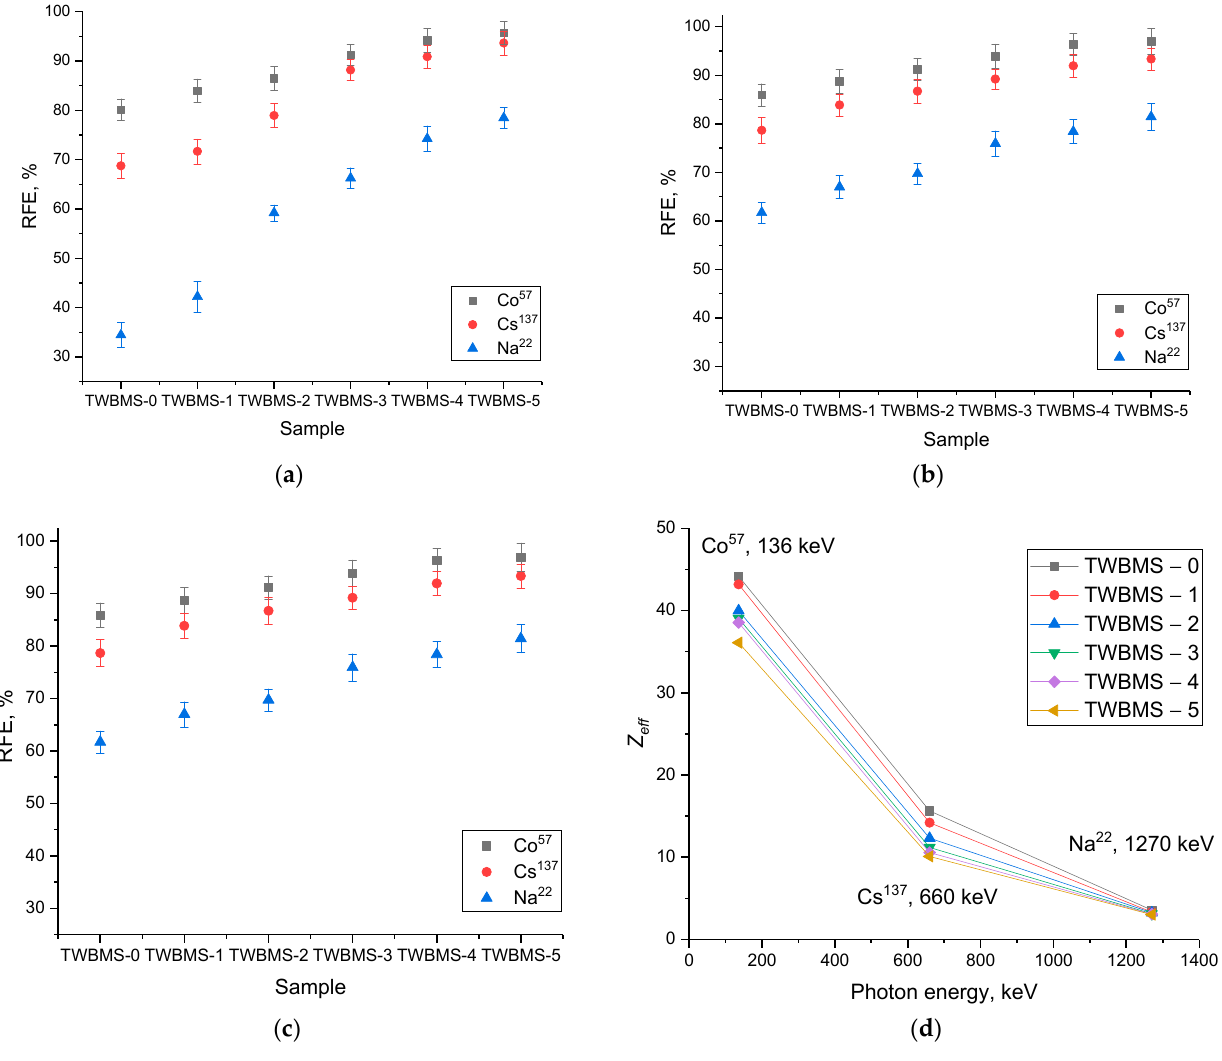
Figure 2. Results of RFE calculations depending on glass thickness: ( a ) 1.0 mm; ( b ) 1.5 mm; ( c ) 2.0 mm; ( d ) the results of calculating the value of Z eff.